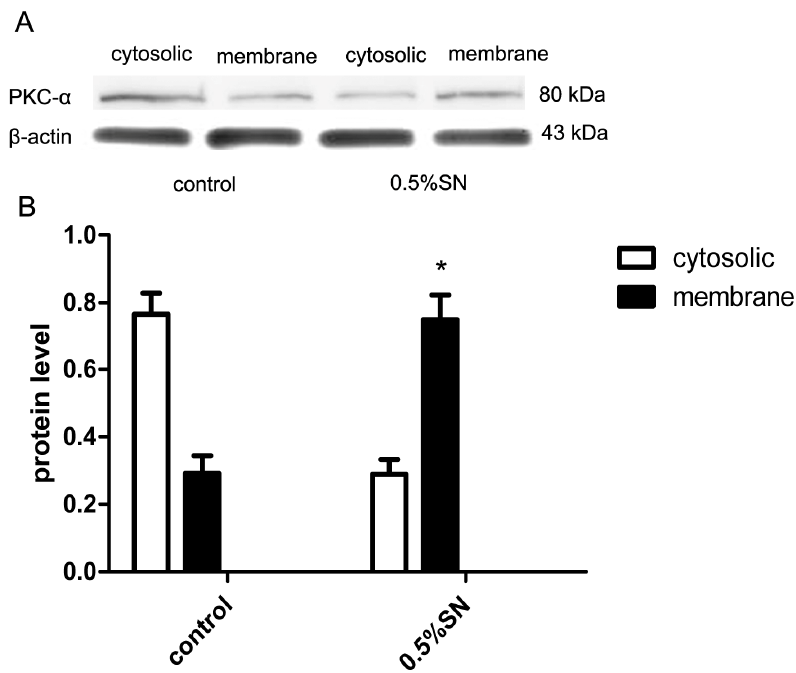
Figure 6. The protein level of PKC- α expressed in different group. ( A ) Western bolt data showed the PKC- α protein expression level in cytosolic and membrane of Caco-2 cell monolayers from control and 0.5% SN treatment group groups, respectively; ( B ) Quantitative data showed the ratio of band density of the corresponding PKC- α protein to that of β -actin in every group. The expression level of PKC- α protein in membrane was increased in 0.5% SN treatment group than in control group (* p <